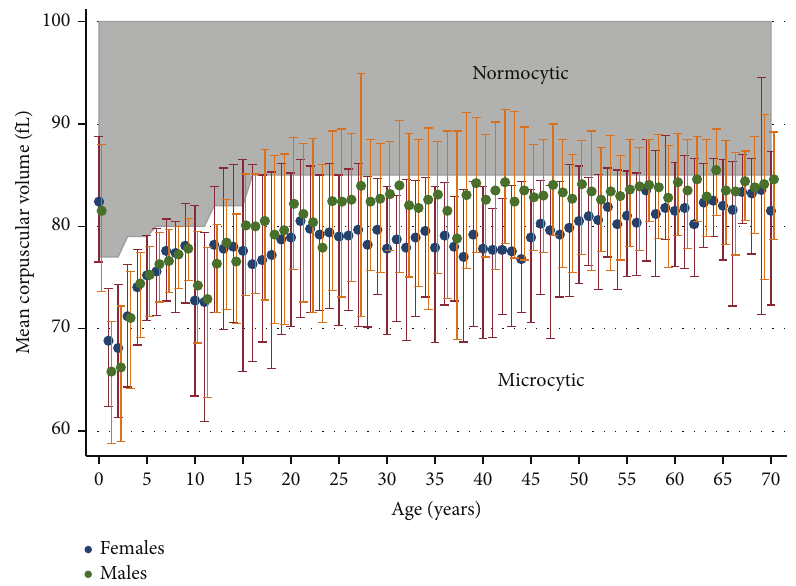
Figure 4: Median and interquartile range of the mean corpuscular volume in patients with anaemia stratified by gender and age.